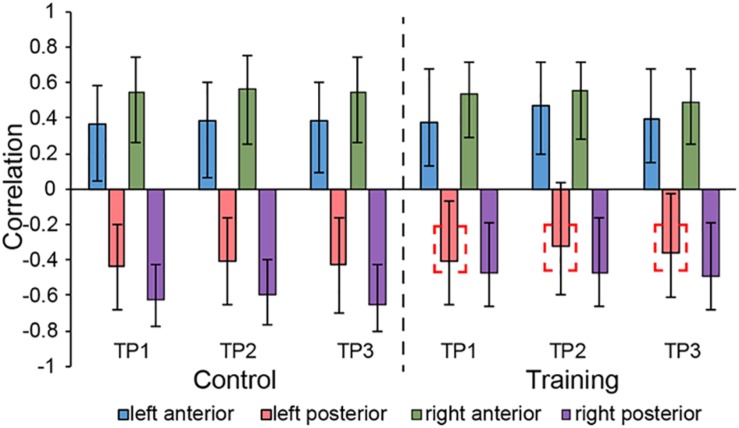
Correlations between brain scores and seed-region volumes in LV3, showing a special structural covariance pattern of aHC in both group across three time points, which is different from the covariance pattern of pHC. For training group, the correlation of left pHC was only significant at TP1 and TP3 other than the TP2 and the red dotted box is used for indicating the left pHC across three time points. Bars describe the relation of each seed to the structural covariance pattern. The error bars represent 95% bootstrapped confidence intervals. A lack of overlap in interval indicates reliable difference for any two correlations and overlap with 0 means the correlation is not significantly different from 0.